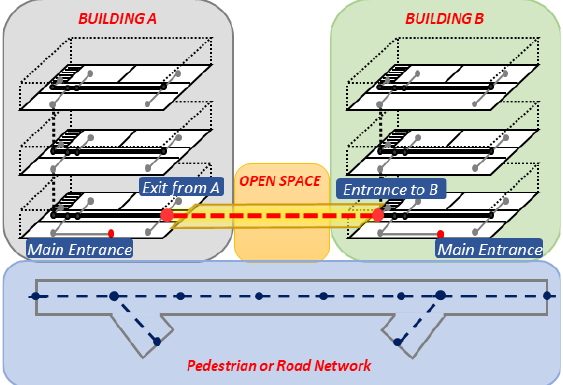
Figure 9 . Connecting transitions between two indoor